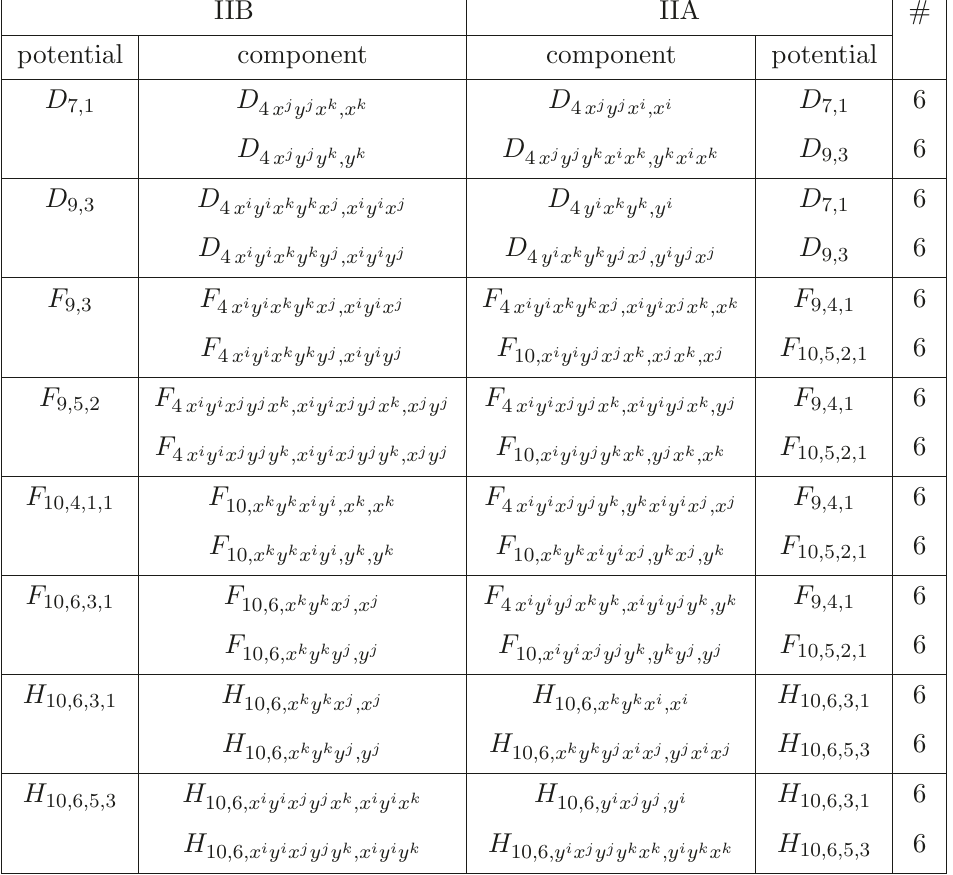
Table 7 . The branes with α even that are forbidden by the N = 1 supersymmetry and give rise to non-trivial Bianchi identities. The total number of such branes is